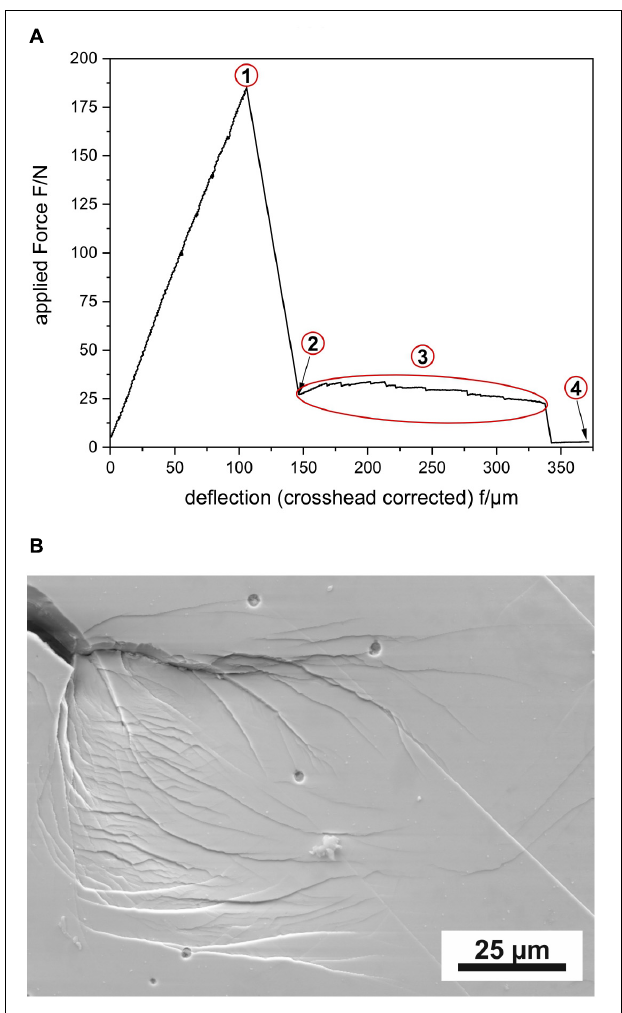
FIGURE 9 | (A) Force deflection curve of pre-notched three-point-bending (3PB) sample in air (images of corresponding crack propagation are depicted in Figure 8 and (B) scanning electron microscopy (SEM) image of the crack tip after testing.